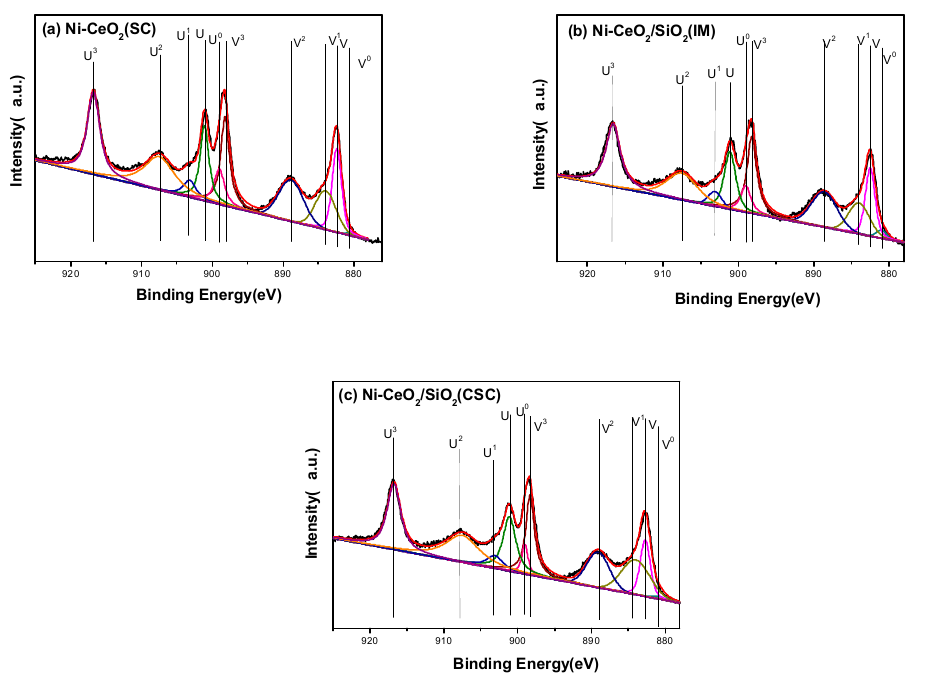
Figure 6. Ce 3d X-ray photoelectron spectroscopy (XPS) spectra of the catalysts: ( a ) Ni-CeO 2 (SC); ( b ) Ni-CeO 2 / SiO 2 (IM); ( c ) Ni-CeO 2 / SiO 2 (CSC). Table 3. Surface atomic ratio determined from XPS analysis for fresh